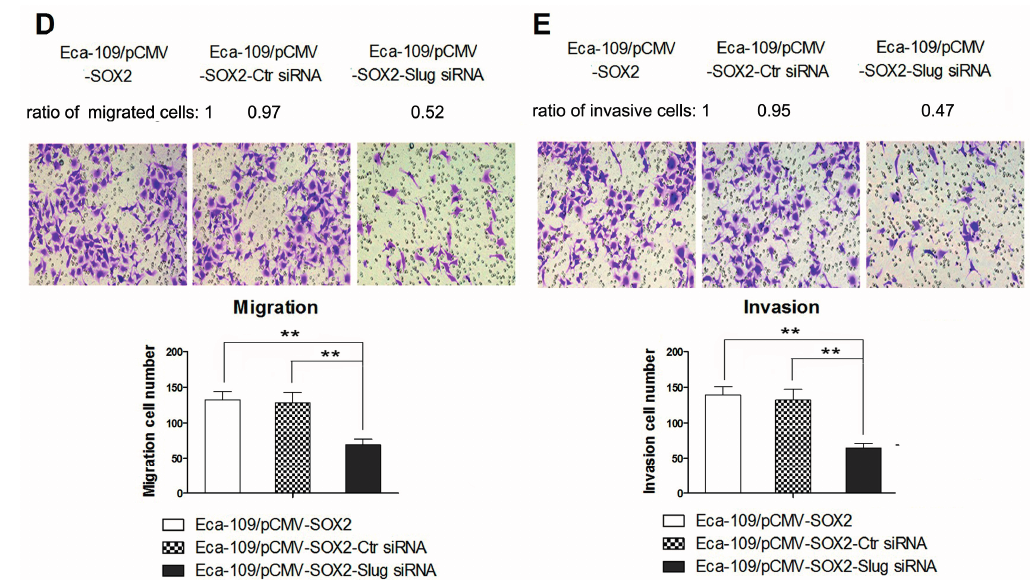
Figure 3. ( A ) The Slug mRNA expression measured by qRT-PCR; ( B ) Western blot showing the expression of Slug protein; ( C ) Western blot showing the effect of Slug knockdown on the expression of epithelial and mesenchymal markers in SOX2 overexpressing cells; ( D , E ) Effect of Slug knockdown on cell migration and invasion assessed by Transwell chamber assay without or with Matrigel, respectively (200× magnification). Data are represented as mean ± SD of three independently conducted experiments. ** indicates p < 0.01. Transwell chamber assay images and Western blots represent three independent experiments (The other two Western blot image were provided as Figure